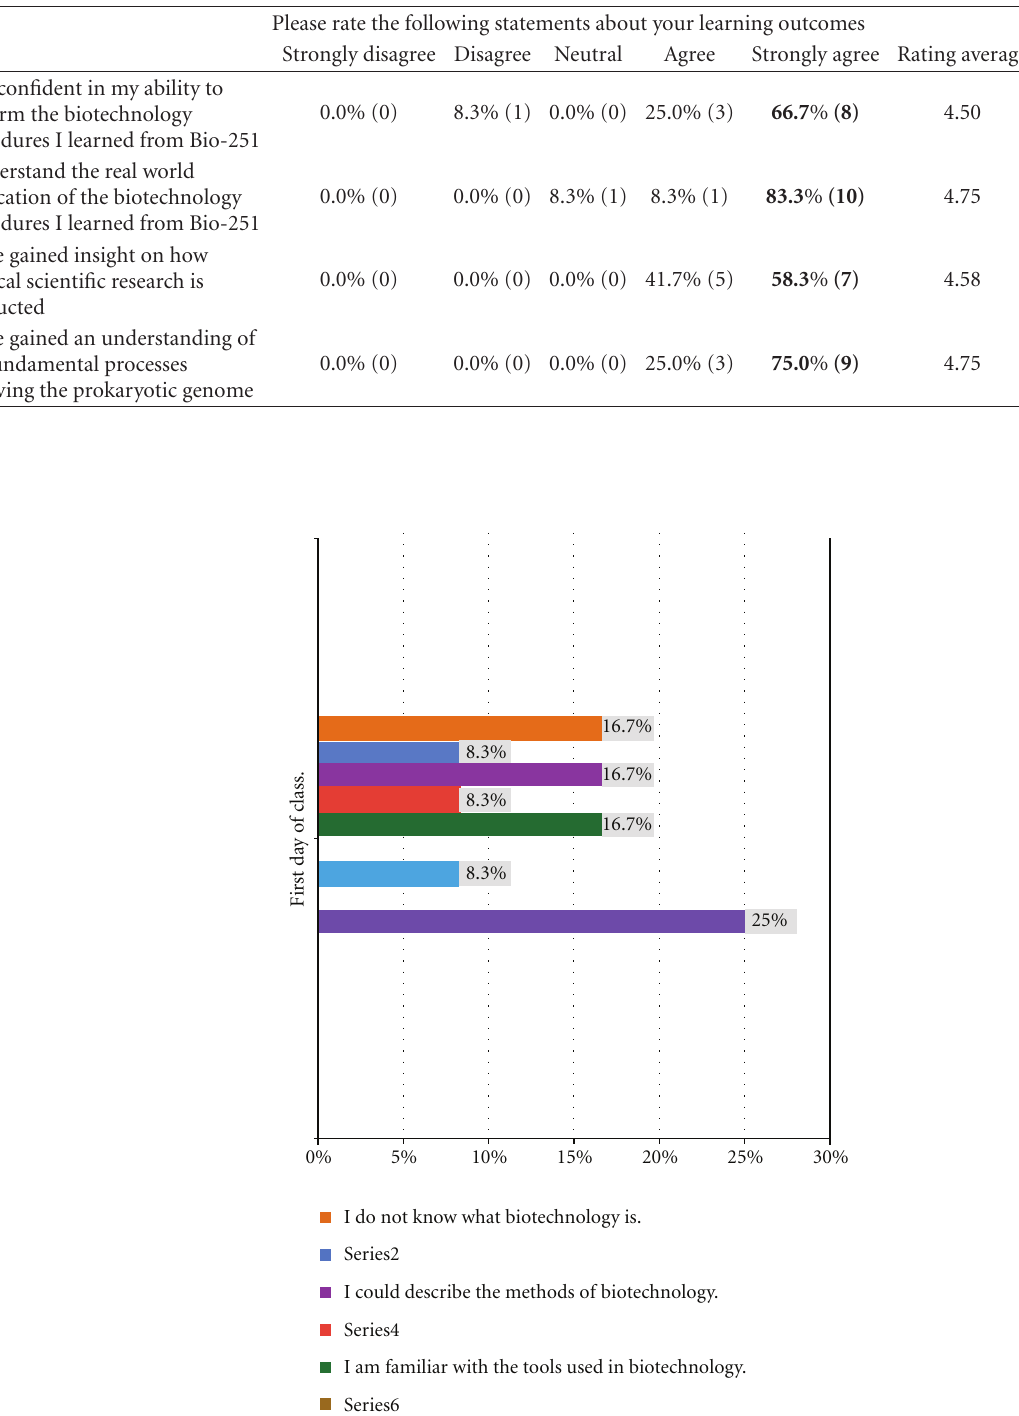
Table 2: Survey Excerpt: Students’ reflections on their own learning outcomes.